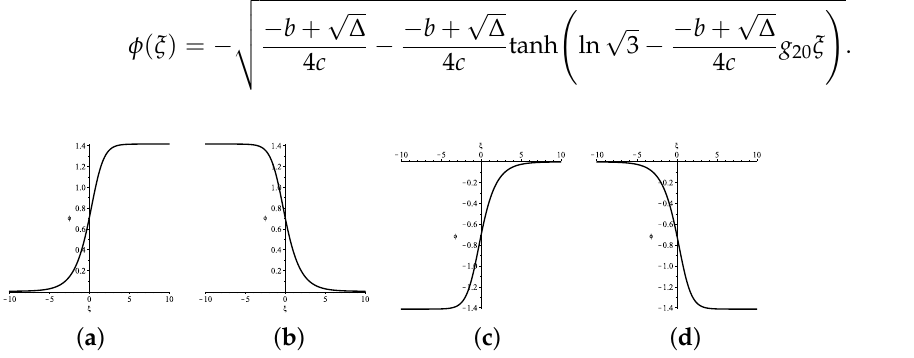
Figure 31. Kink and anti-kink wave forms of system (5). ( a ) Kink wave given by (76). ( b ) Anti-kink wave given by (77). ( c ) Kink wave given by (78). ( d ) Anti-kink wave given by